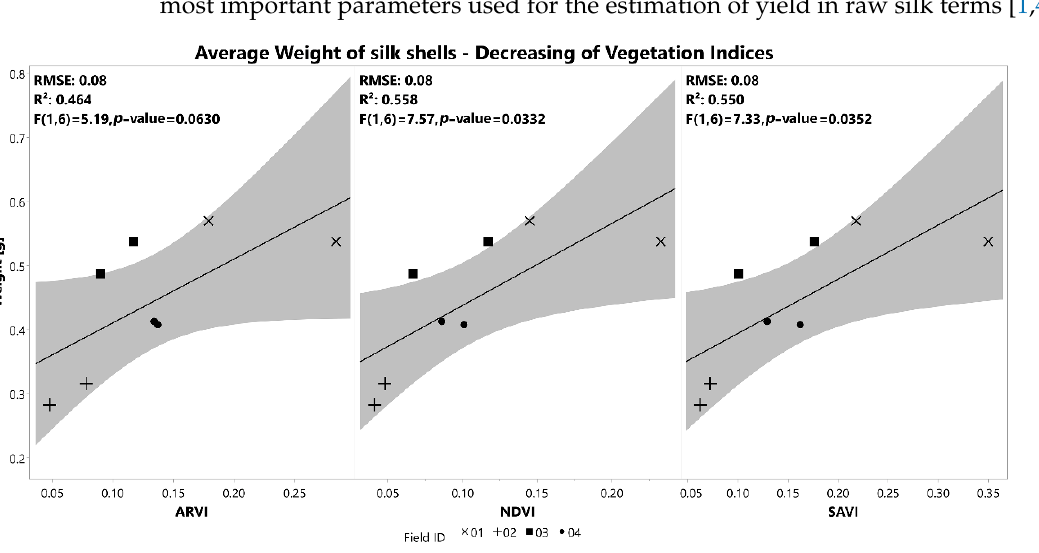
instar of B. mori . Gray shaded areas represent the confidence interval of regression at 95%.